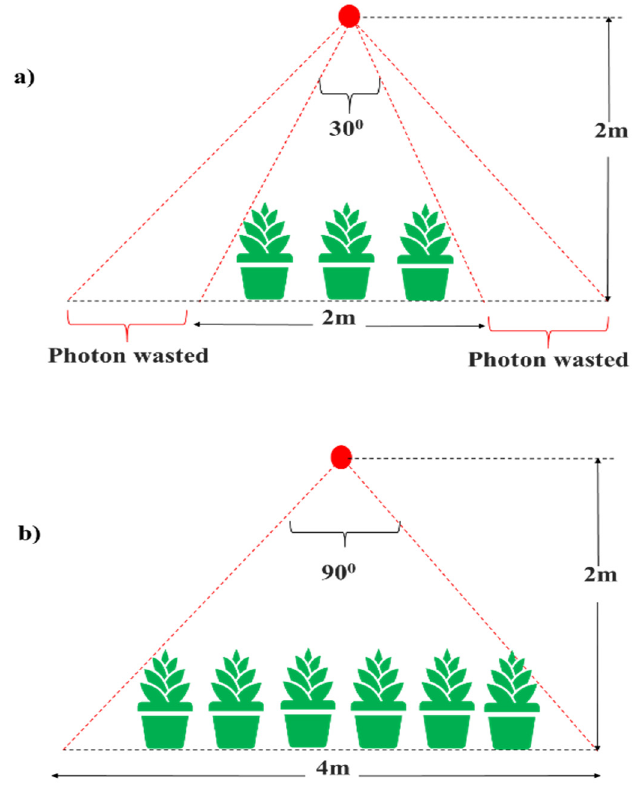
Figure 1. Impact of the PPF uniformity on the canopy photon capture efficiency. The canopy’s photon capture efficiency ( a ) decreases as the lighting’s fixture gets smaller and ( b ) increases as the installation of lighting gets more prominent. This concept and picture are modified [30].